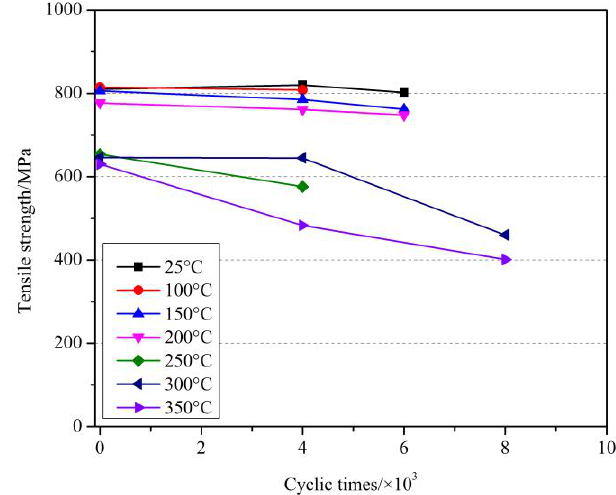
Figure 6. The effect of cyclic load on the tensile strength of GFRP bars after elevated temperatures with a holding time of 0 h.